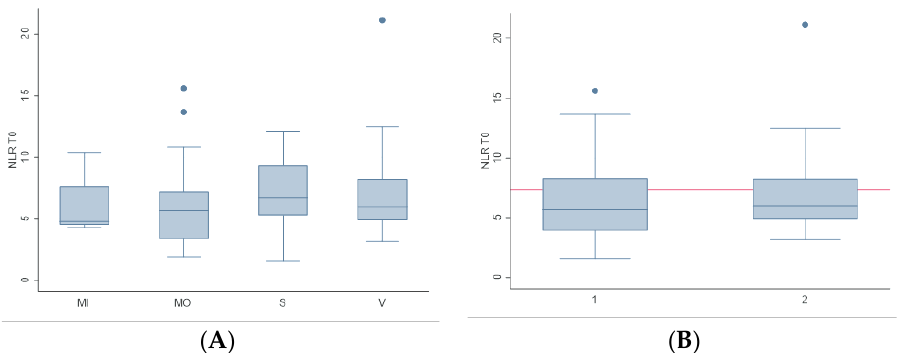
Figure 2. The relationship between the disease severity groups (MI, MO, S and V) and the NLR are graphically represented (A). The red line represents the optimal NLR cutoff to distinguish the group with very severe clinical signs (V = 2) from the other groups (MI + MO + S = 1) as given by the nonparametric ROC analysis (B).